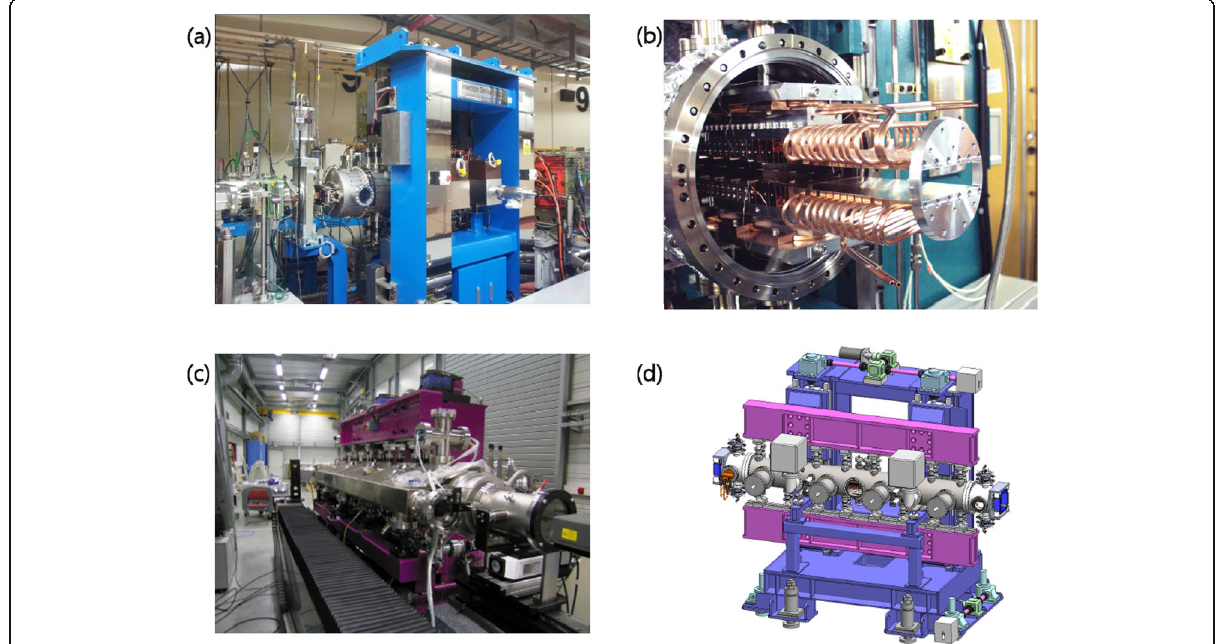
Fig. 3 In-vacuum undulator in 3GSR. a In-vacuum undulator in PLS-II. b In-vacuum undulator in ALS. c Cryogenic in-vacuum undulator in ESRF. d In-vacuum undulator in TPS